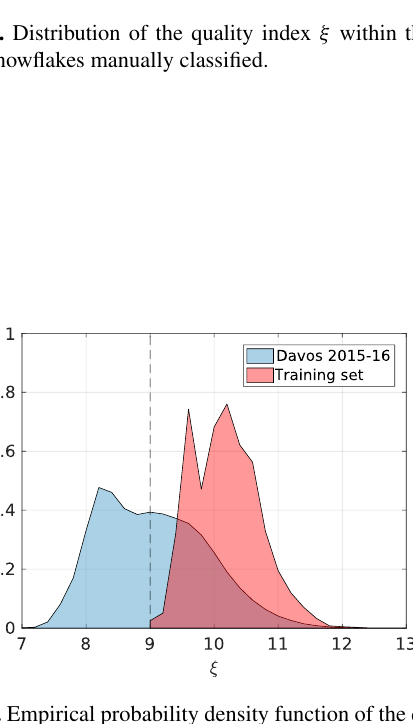
Figure B2. Empirical probability density function of the quality in- dex ξ for the training set and for the whole measurement campaign in Davos. The threshold at ξ = 9 is